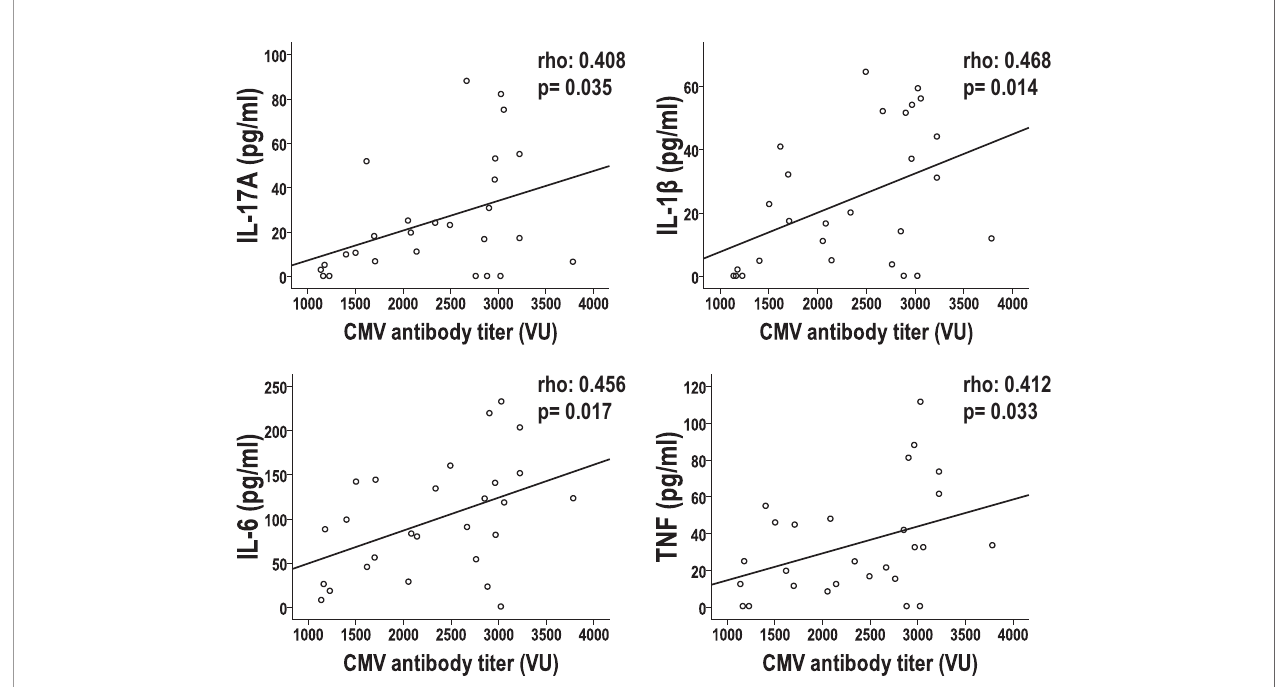
FIGURE 3 | Relationship between anti-CMV antibody titer with cytokine levels inCHFpatients. The correlation ofanti-CMV antibodytitersand cytokine levels inCHF patients isrepresented in the dot plots. Spearman ’ s test was applied to calculate the correlations; the p-valueand coef fi cient of correlation are listed on